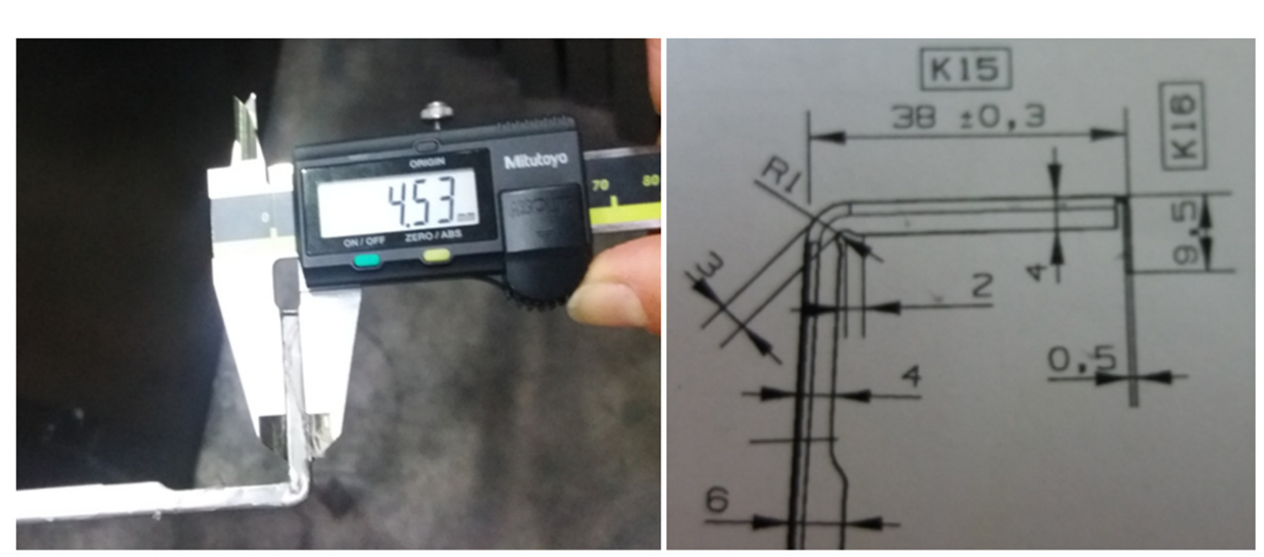
Figure 5. Performed measurements. The measurements taken by the two operators are displayed in Table 4. Based on the measurements, we find that the average value of the measured values is 4.75 Table 4. Two operators’ collective measures. No.